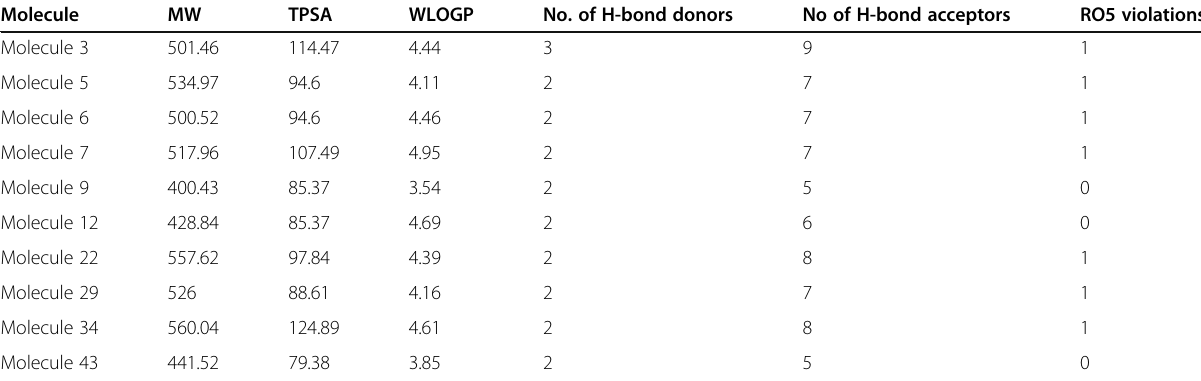
Table 2 Drug-likeness properties of ten top compounds Molecule MW